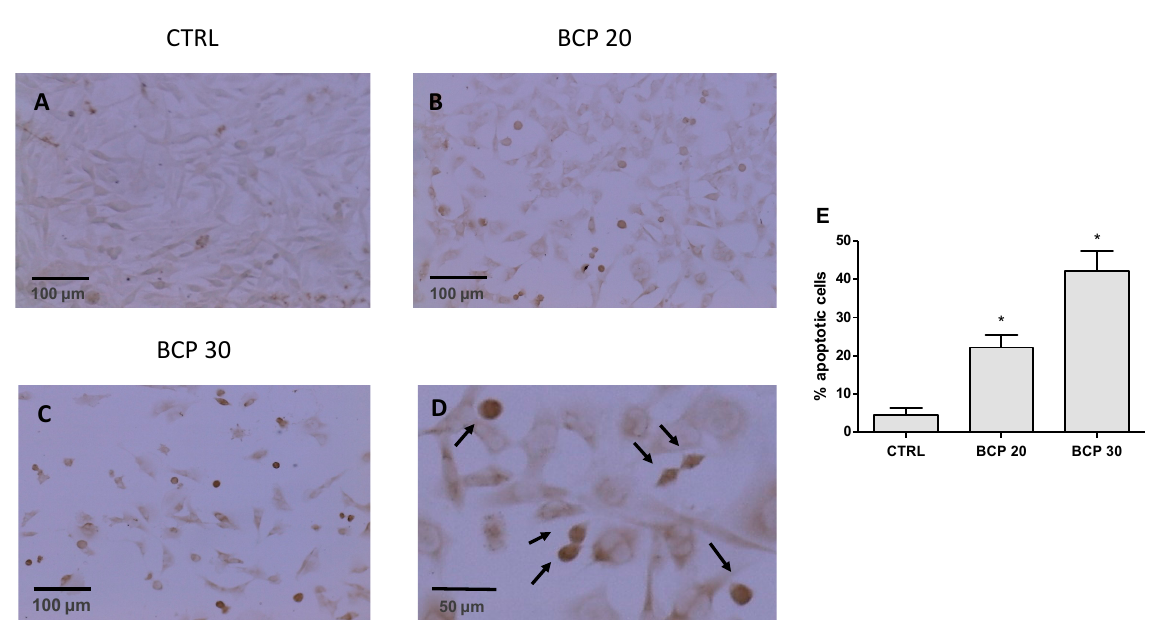
Figure 2. Effect of BCP on apoptosis induction in U373 cells. The detection of apoptosis was assessed by TUNEL (Terminal deoxynucleotidyl transferase dUTP nick end labeling) assay. In the images (panels A – C ; scale bar = 100 µ m), brown color reaction indicates cells that underwent apoptosis. Panel D shows cells at higher magnification (scale bar = 50 µ m) and TUNEL—positive cells are indicated by arrows. Quantitative results are presented as a percentage of TUNEL-positive (panel E ). The data are expressed as the mean ± SD; * p < 0.001 vs. the control.